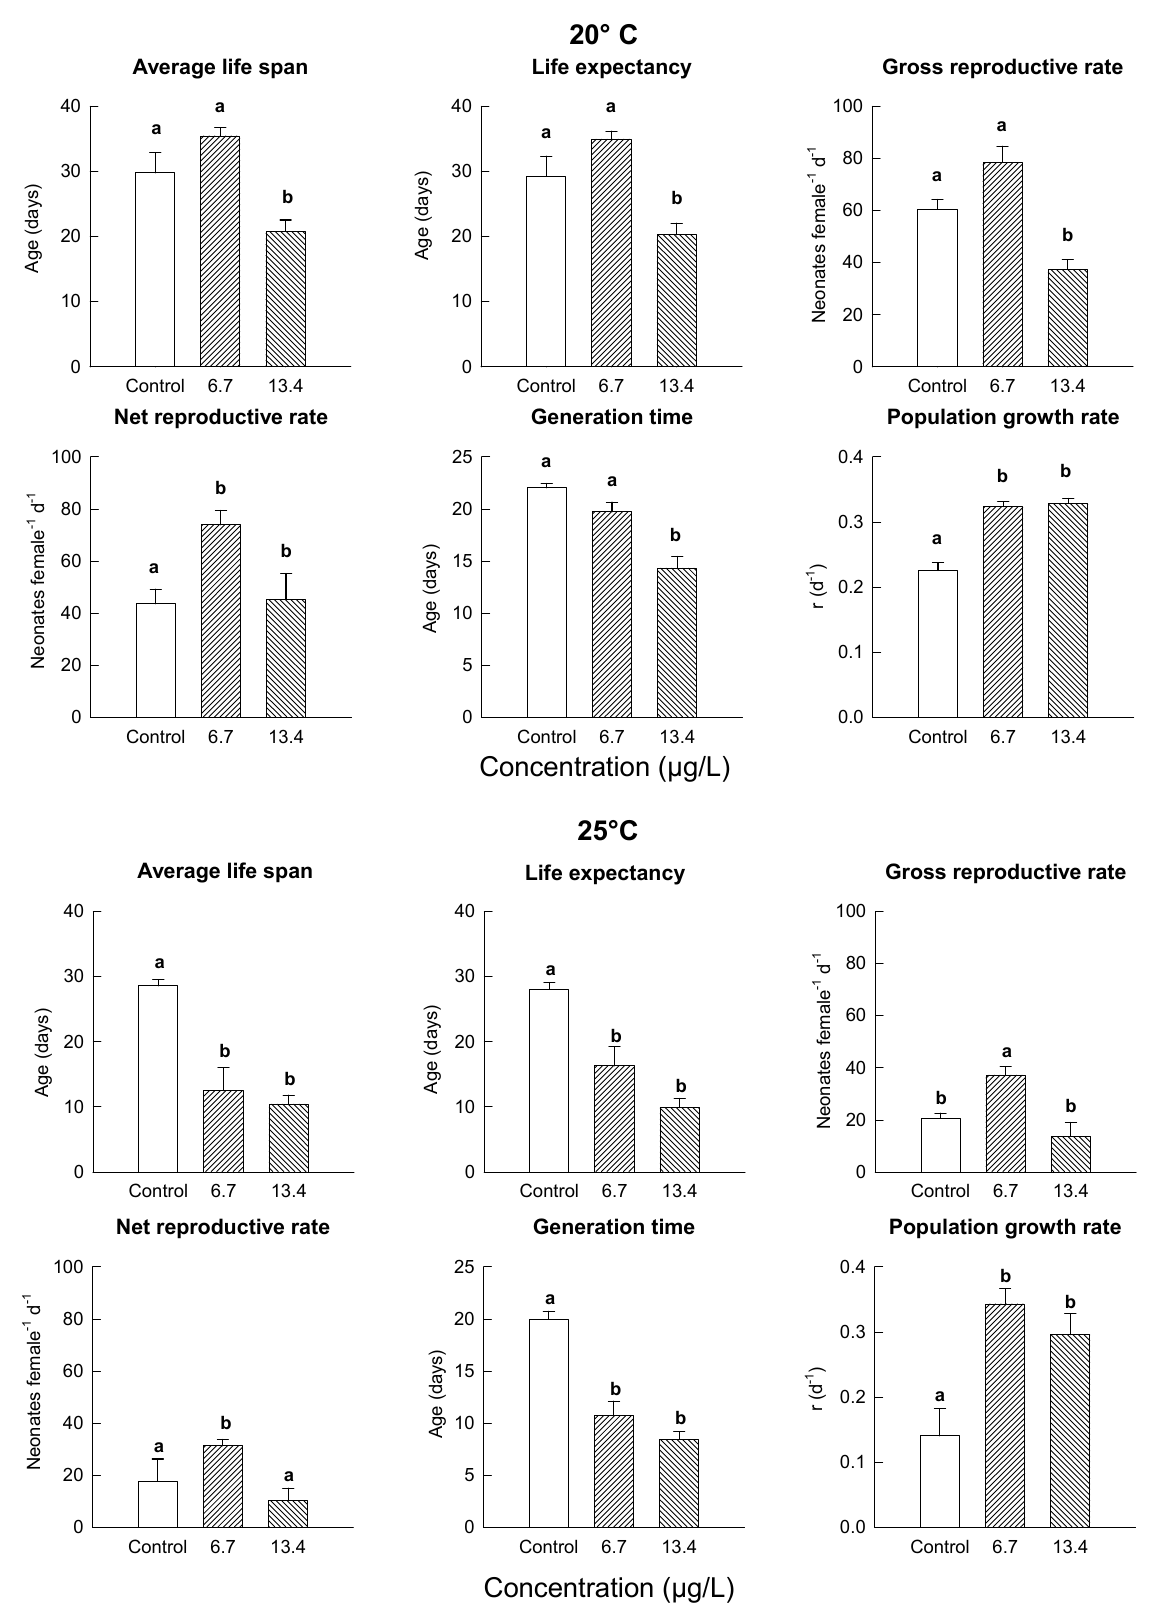
Figure 4. Life history variables of Daphnia pulex exposed to cyanobacterial extracts from blooms of Microcystis (January) at 20 ◦ C and 25 ◦ C. Shown are the means ± SE based on four replicate recordings. Data bars carrying different alphabets for a given variable are significantly different ( p <